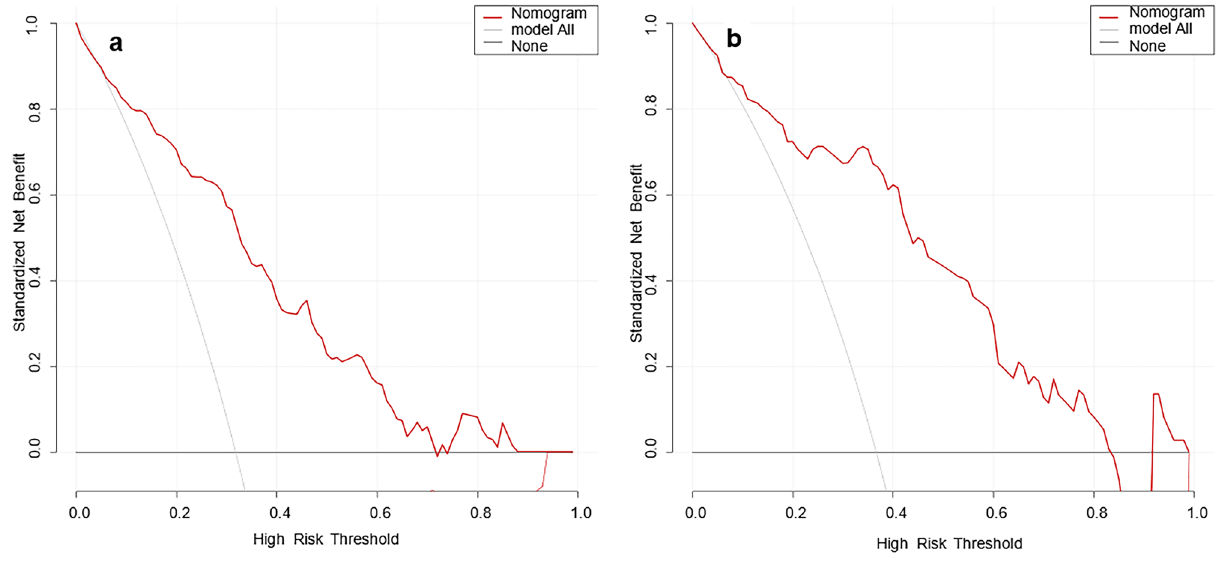
Figure 4. DCA curves of the nomogram model (( a ) training set, ( b ) validation set). The x-axis is the high-risk threshold probability, and the y-axis is the net benefit. The grey and black lines are the extreme curves; the grey line stands for the hypothesis that all patients suffer from MPP; and the black line stands for the hypothesis that all patients do not suffer from MPP. The red line is the DCA curve of the nomogram model, representing the net benefit of the model under different high-risk thresholds. The farther the DCA curve is from the extreme curve, the greater the range of net benefit and the better the clinical